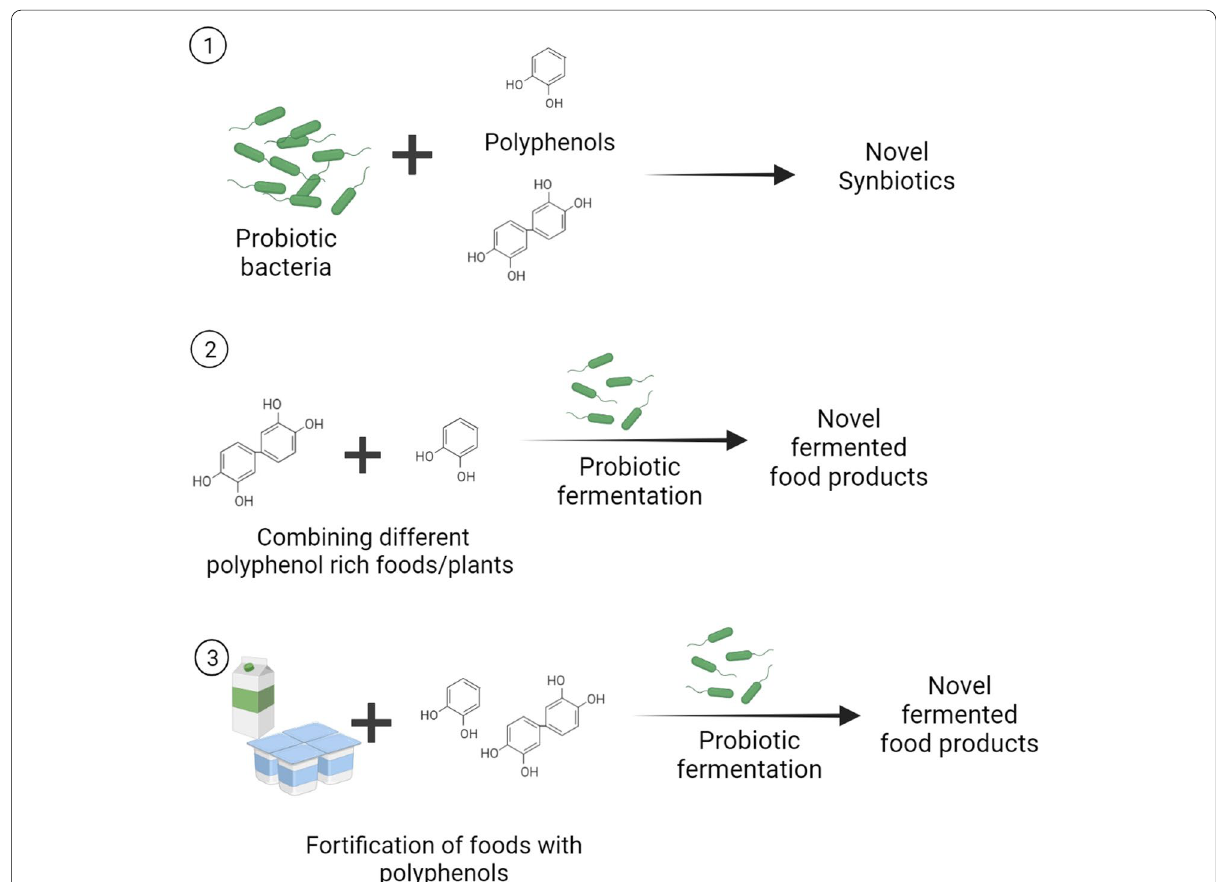
Fig. 4 Different strategies based on polyphenolic and probiotic amalgamation for the development of novel functional foods. 1. Combinations of probiotic bacteria and polyphenols can act as synbiotics with improved functional response 2. Different sources of polyphenols may be combined together and then fermented with specific probiotic bacteria that improves the overall phenolic profile of the combined food product while maintaining its probiotic viability 3. Fortification of foods with polyphenols and their subsequent probiotic fermentation can also enhance their bioactive potential while still preserving the sensory experience in the novel functional